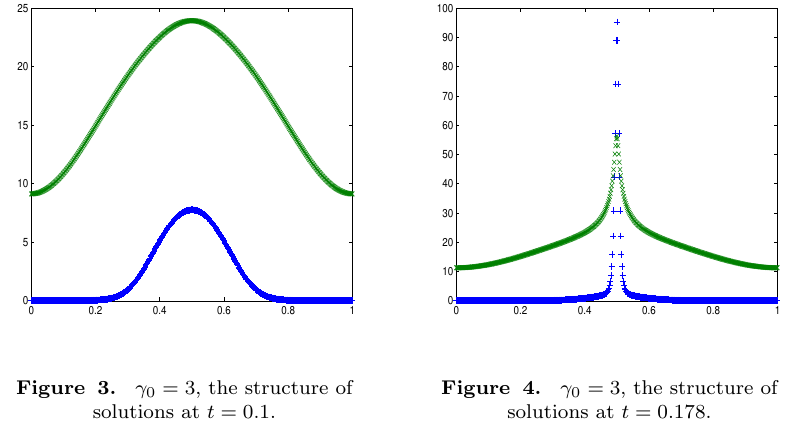
Figure 4. γ 0 = 3, the structure of solutions at t = 0 . 178.